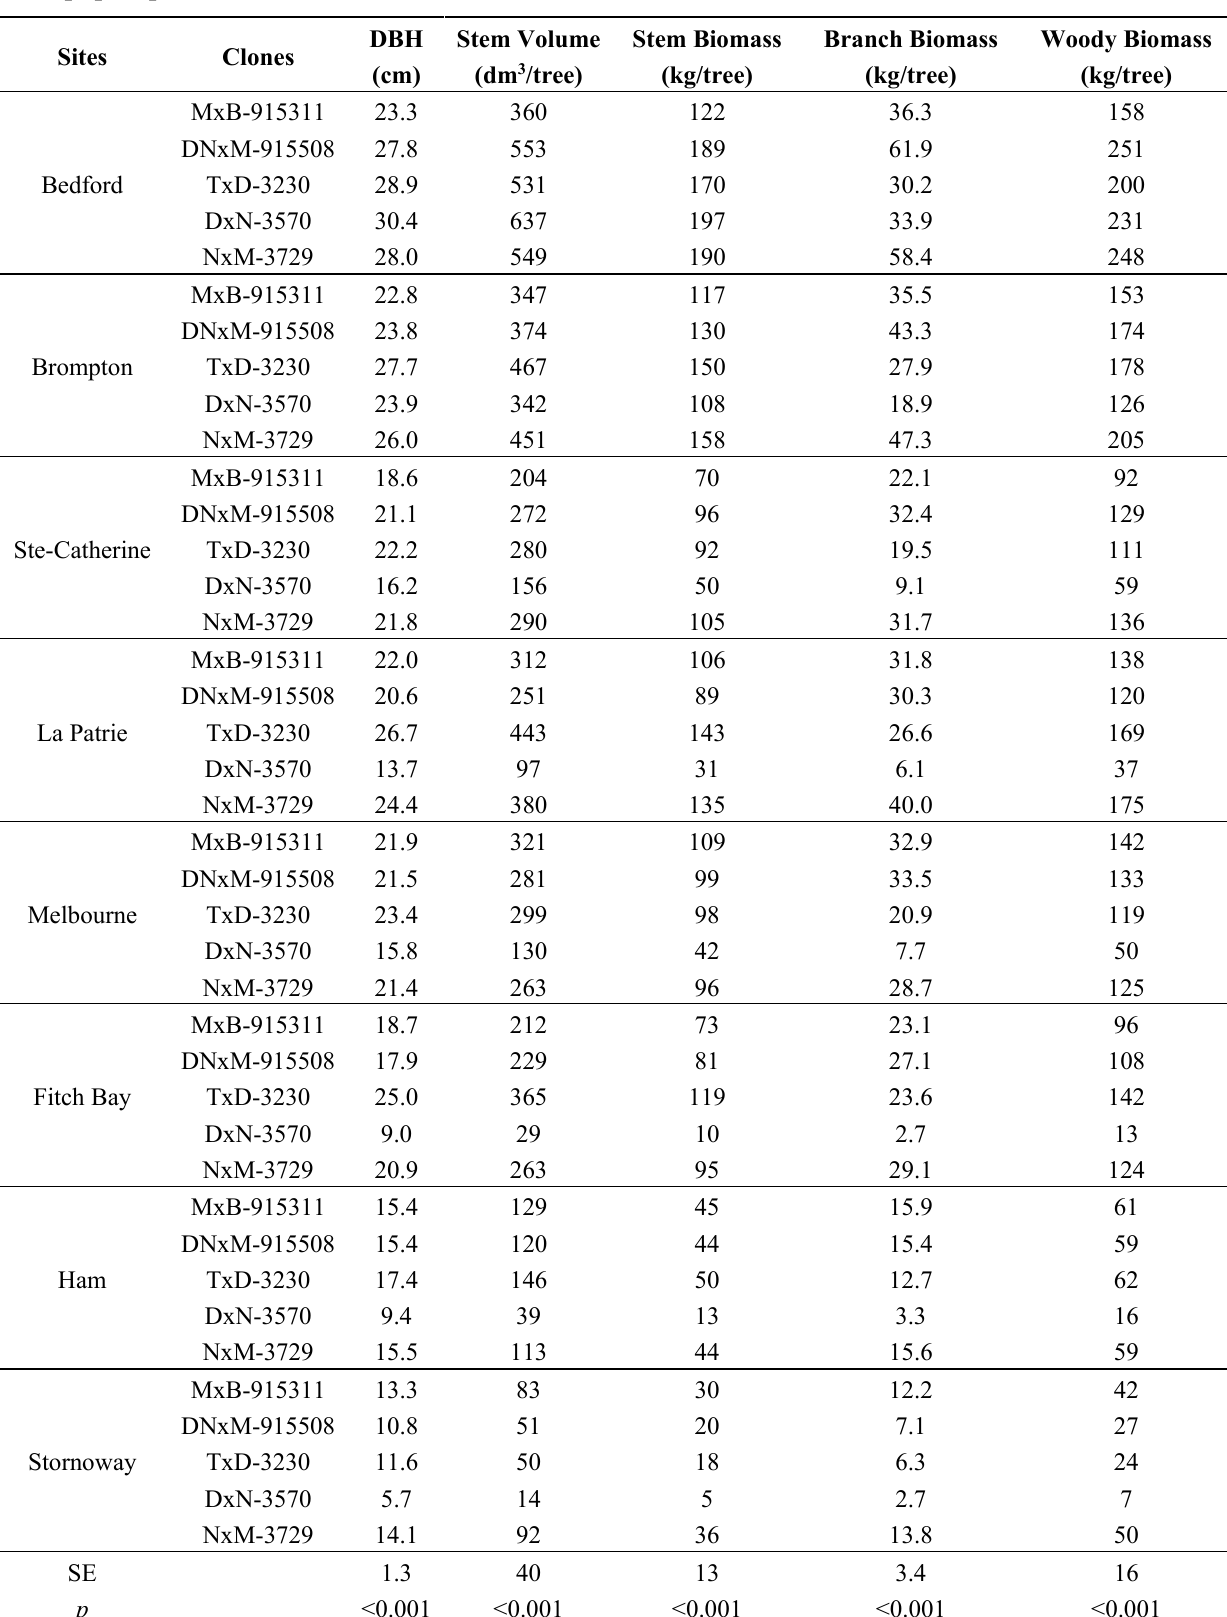
Table 5. Site × Clone interaction for mean tree DBH, stem volume per tree, stem biomass per tree, branch biomass per tree, and aboveground woody biomass per tree in 13 year-old poplar